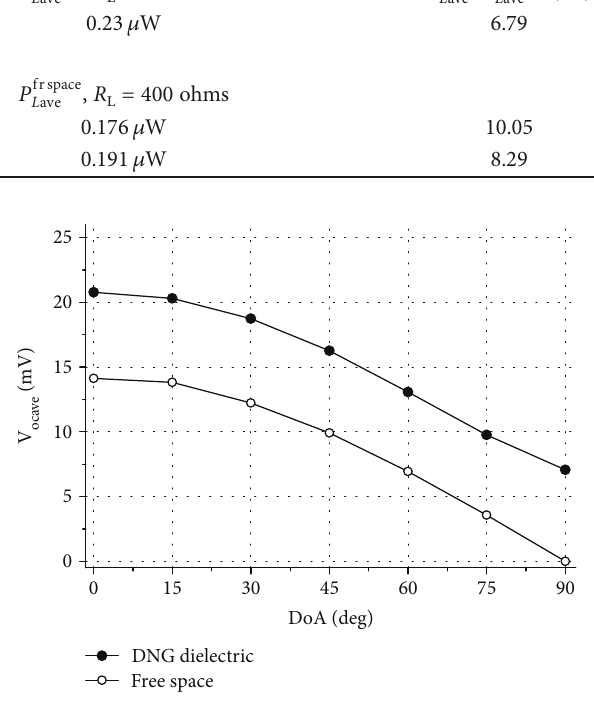
Figure 13: “ Dipole 1 ” in front of the DNG and in free space: V (mVolts) values, calculated over the UMTS band, at the open- circuited input terminals of the dipole, versus the direction of arrival (DoA) of the incoming wave. DoA is considered with respect z